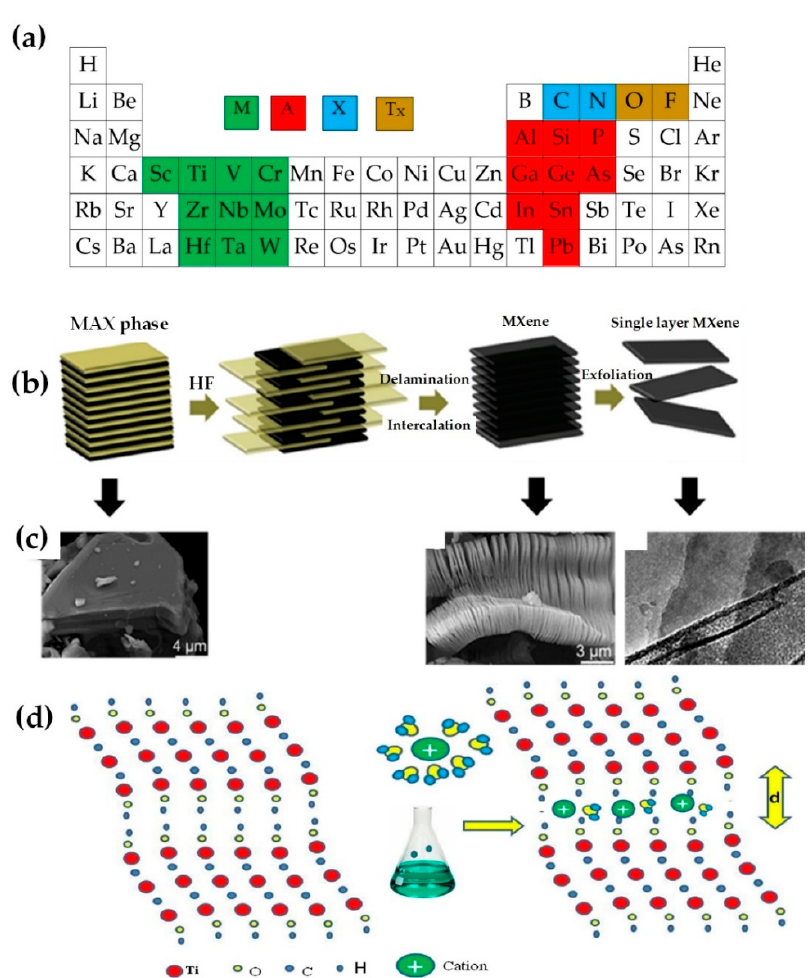
Figure 1. ( a ) Different MAX-phase atoms, ( b ) Top-down synthesis steps of MXene nanosheets from the parent MAX-phase, ( c ) Electron microscope images before and after etching, and exfoliated MXene, reprinted with permission from [28], ( d ) Ions intercalation and delamination in Ti 3 C 2 T x layers, reprinted with permission from